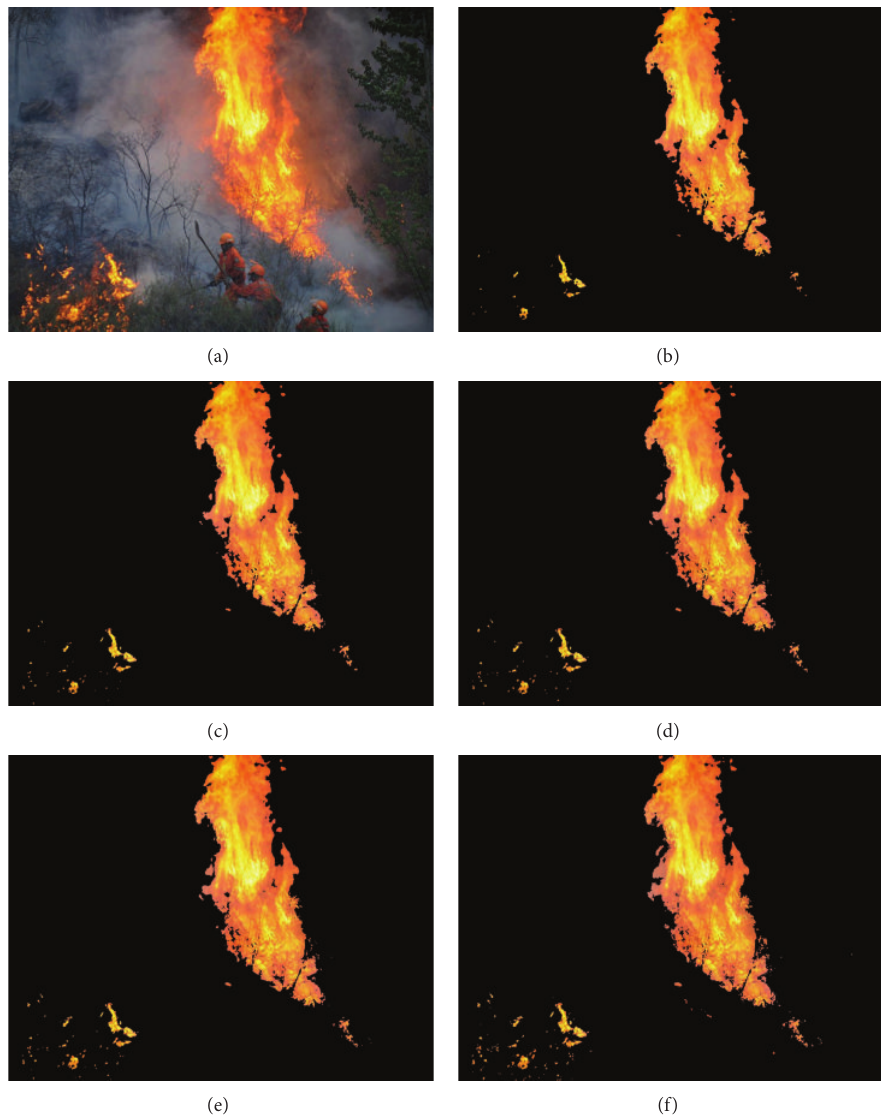
Figure 2: Fire segmentation with different angles 𝜃 : (a) input image; (b–f) results with 𝜃 = 0 ∘ , 30 ∘ , 45 ∘ , 60 ∘ , 90 ∘ .